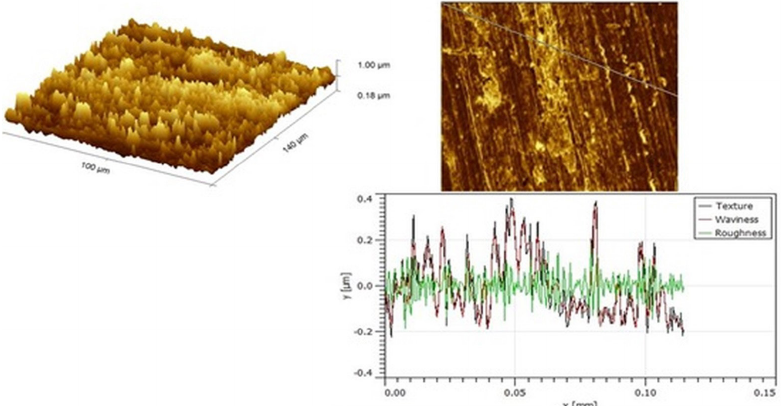
Figure 10. AFM images for the specimen 9 (25N of Load, 1200 rpm of disc speed, 6 m/sec of velocity and wear rate of 0.0893 mm 3